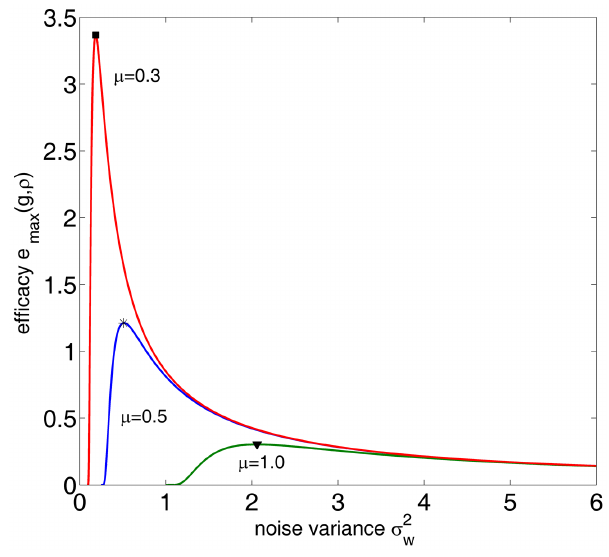
Figure 3. Suprathreshold stochastic resonance in an array of threshold neurons. Detection efficacy e max ( g , r ) as a function of the internal uniform noise level b and the neuron array size M . From the bottom upwards, M ~ 1,2,5,10,100,1000, ? . Here, the initial Gaussian noise level s w ~ 0 : 3 , the transfer function g ( x ) ~ sign ( x ) , the correlation coefficient (a) j r j ~ 0 : 2 and (b) j r j ~ 0 : 3 .